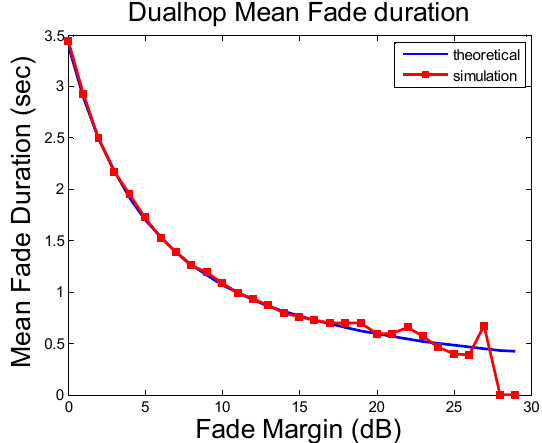
Figure 3. Theoretical and simulated outage duration for a dual-hop link vs. fade margin.